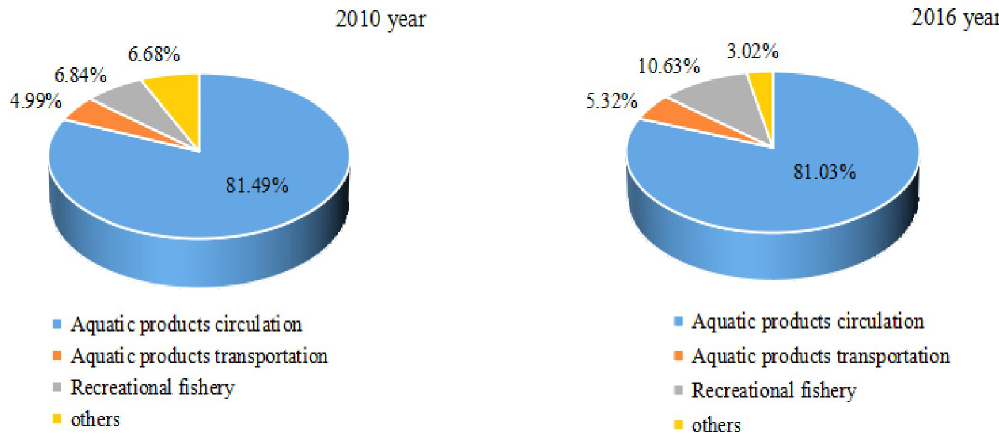
Fig 6. Industrial distribution in the tertiary fishery industry (2010, 2016).